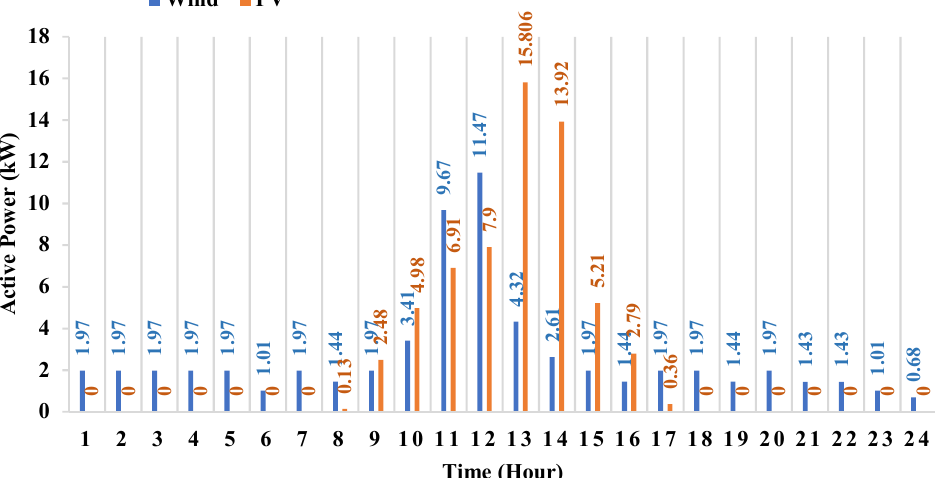
Figure 5. Estimated output powers (normalized) of PV and WT [40]. Table 1. The limits and bids of DG sources and the utility grid [41].